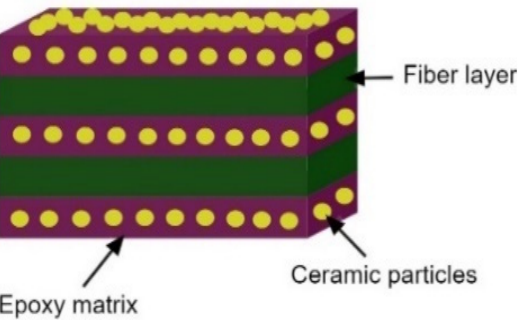
Figure 3. The sandwich-structure of processed SiC ceramic embedded E-glass fiber reinforced epoxy matrix composites.